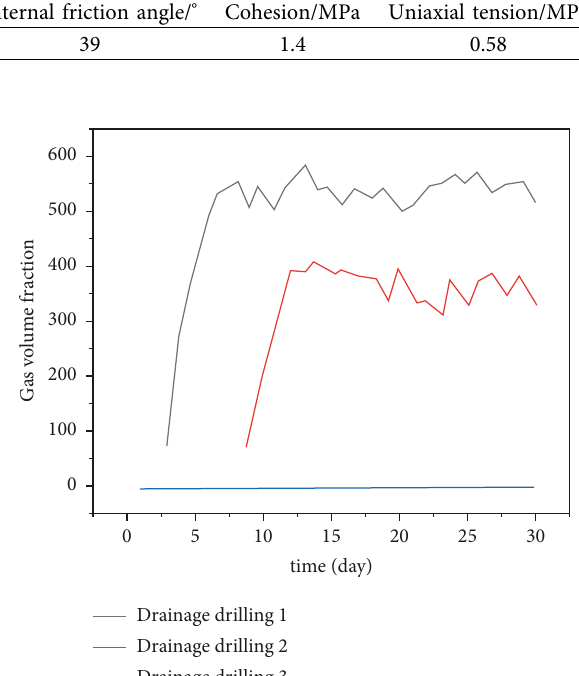
Figure 4: Variation curve of tracer gas volume fraction in ex- perimental pumping boreholes with gas burst antireflection